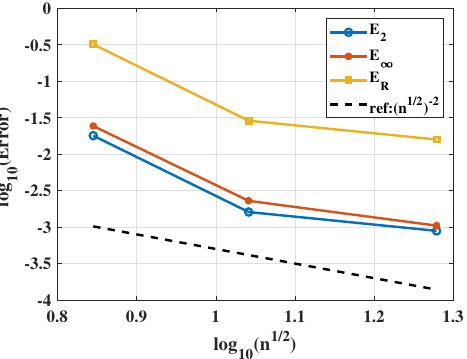
Figure 3. Diagram of the DoFs vs. the error between the numerical and analytical solutions in